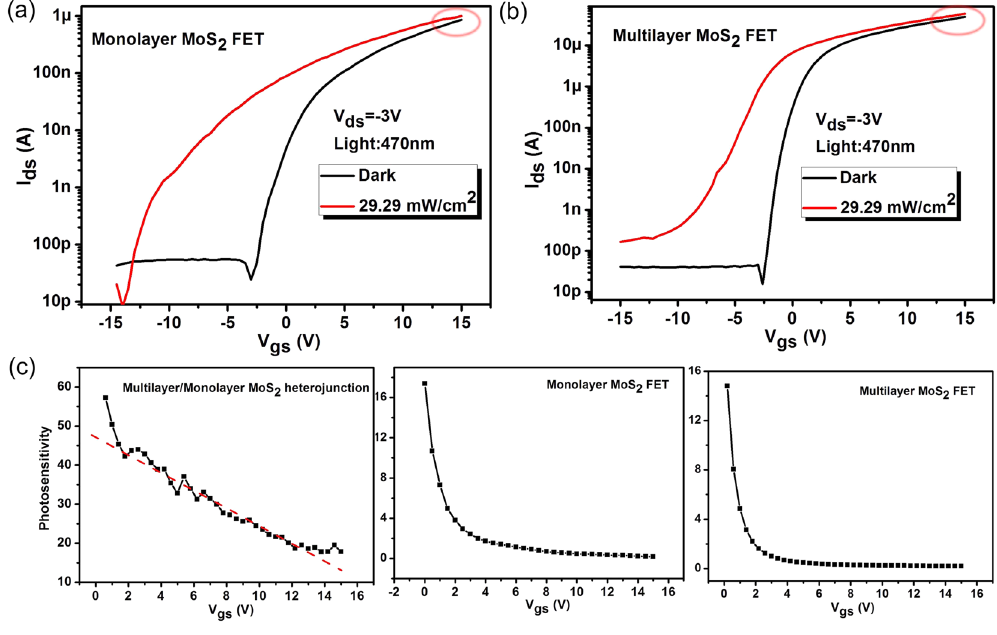
Figure 5. ( a and b ) The transfer curves of monolayer MoS 2 and multilayer MoS 2 photo-transistors. ( c ) The photosensitivity changes of three kinds of devices with the change of gate